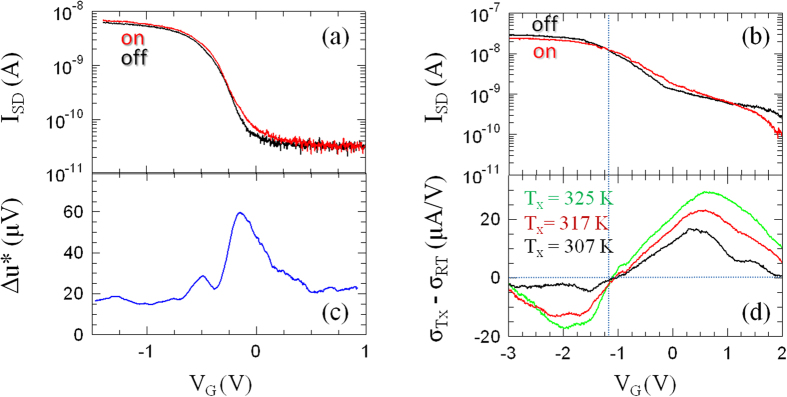
Transport characteristics.(a,b) Room-temperature (RT) transfer characteristics of sample A (a) and B (b) measured while sweeping VG, by keeping VSD = 0.2 mV and while a 0.29 THz beam was impinging on the device (ISD,on) or when it was blanked (ISD,off). ISD was amplified by a factor 106 by using a transimpedance amplifier. (c) dc photovoltage trend vs VG, measured from the difference between the ISD,on and ISD,off, multiplied by the channel resistance. (d) Gate voltage dependence of the difference between the RT conductance and the conductance measured at Tx, in the three different cases in which Tx = 307 K, 317 K, 325 K. The dashed vertical line identifies the transition between the regime in which γ = dσ/dT < 0 (degenerate semiconductor) and γ > 0 (non-degenerate semiconductor).